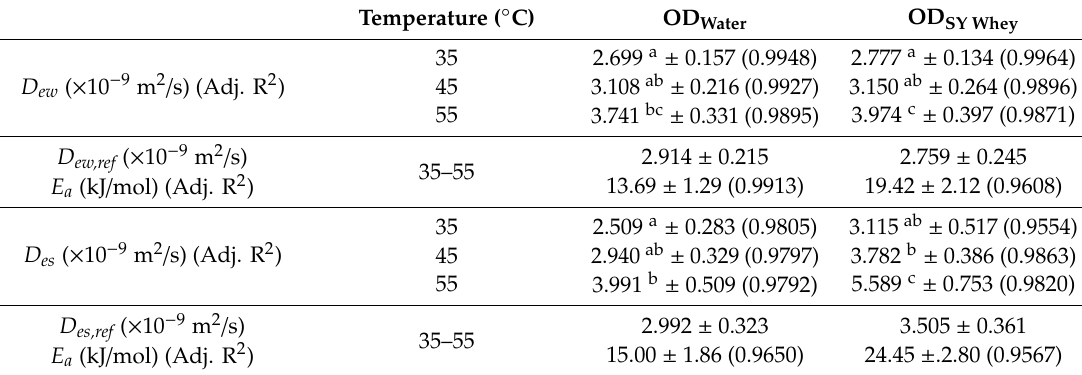
ff erent ( p < 0.05),